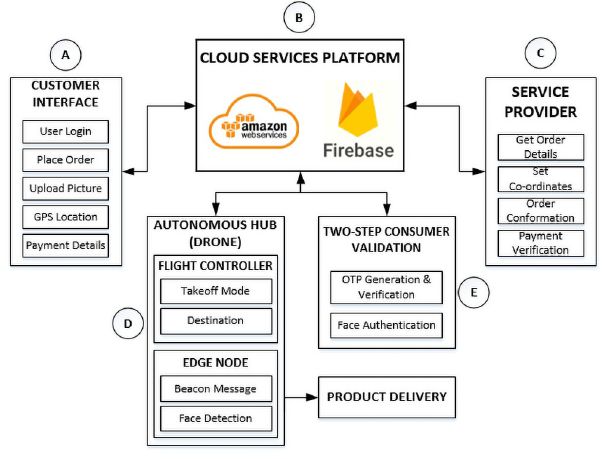
Fig 1. Block diagram of the proposed consumer authentication (Consumer-Auth)